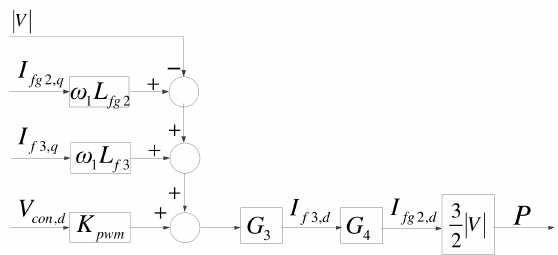
Figure 11. D-axis mathematical model of the MG